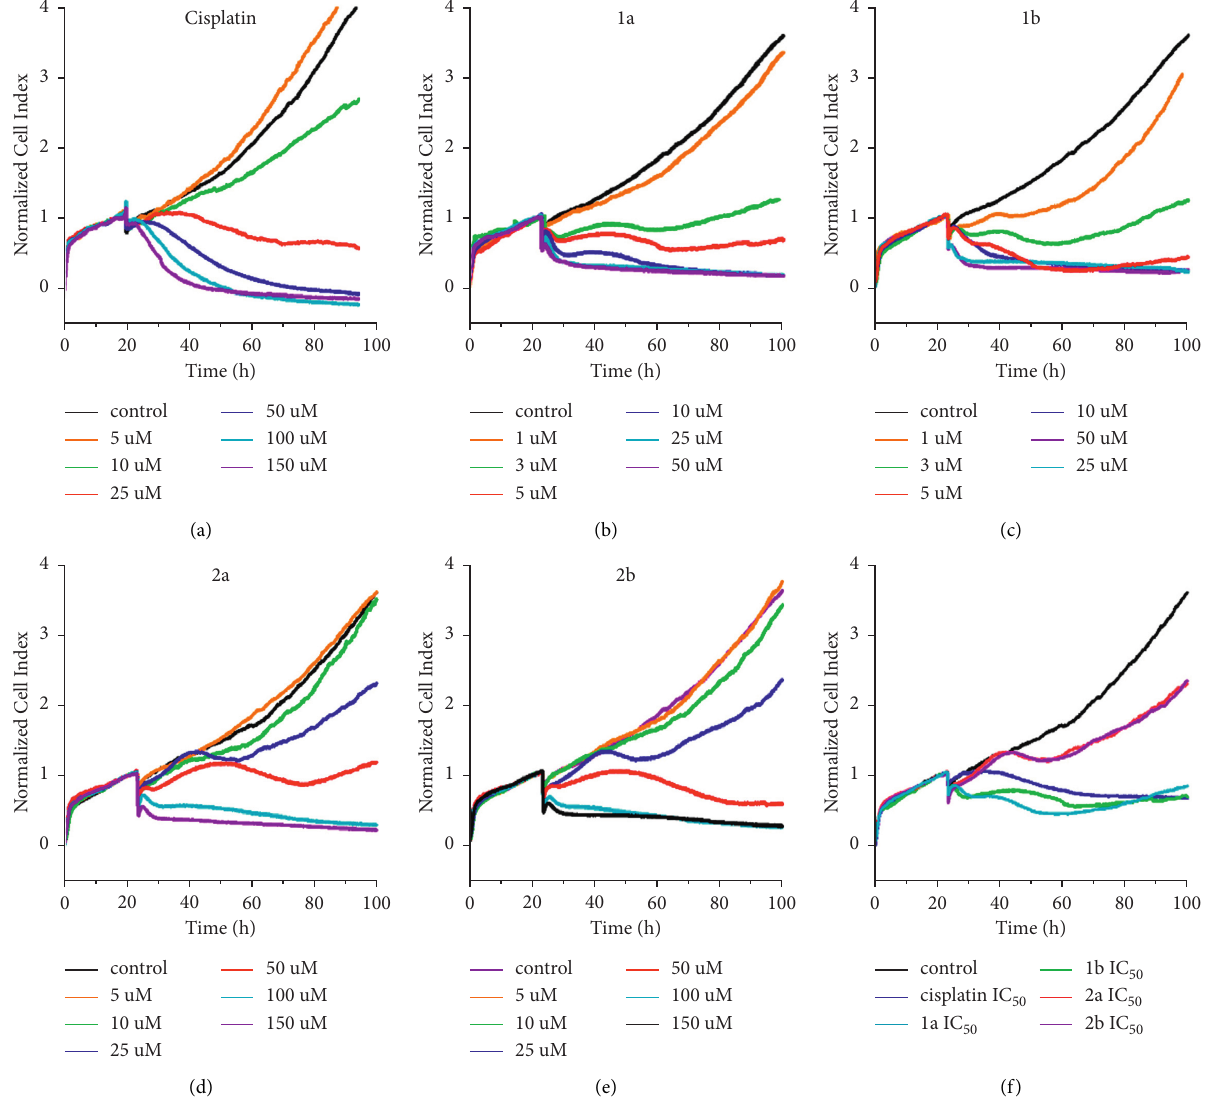
Figure 7: Interaction of MDA-MB-231cells with cisplatin (a), 1a (b), 1b (c), 2a (d), and 2b (e) monitored by a real-time cell analyzer (RTCA). (f) A comparison of RTCA profiles was found for 1a , 1b , 2a , 2b and cisplatin at their equitoxic concentrations (IC 50,72h ). The vertical lines indicate the start of the treatment after allowing the cells to adhere to microelectrodes and grow for 24h. Cell indices were normalized to account for differences in cell counts that existed across the wells before the treatment. Incubations were performed in triplicate with 3000cells per